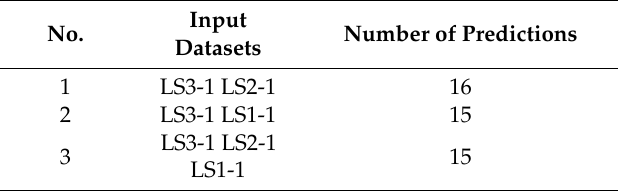
Table 5. Accuracy evaluation of landslide comprehensive